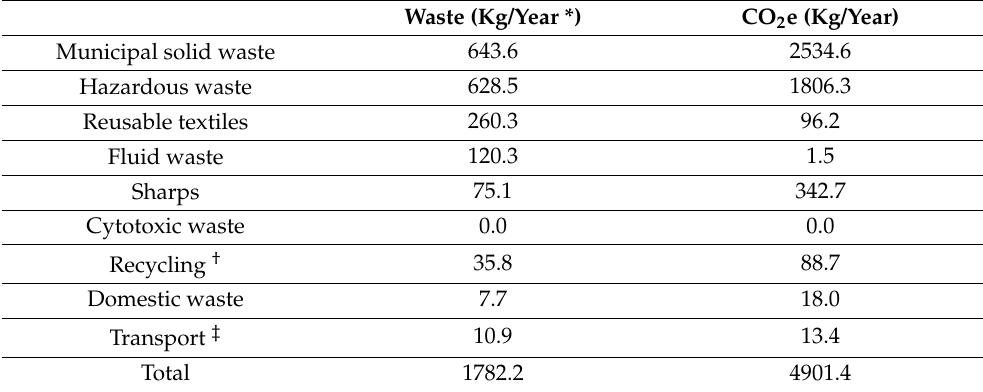
Table 2. Waste volumes secondary calculated greenhouse gas emissions due to neurosurgical con- sumables per neurosurgical trainee (200 cases operated on within 12